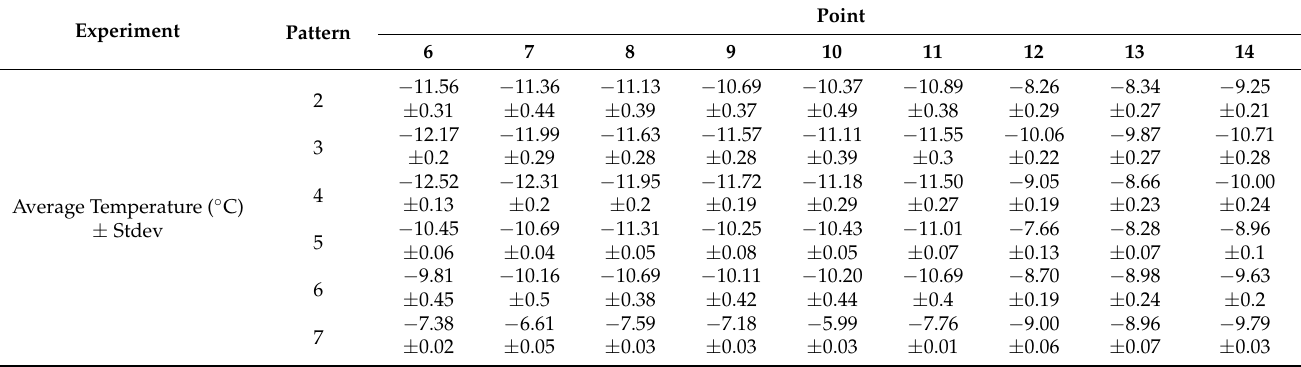
Table 5. The average lowest temperature values of boxes temperature measured over 1 h.